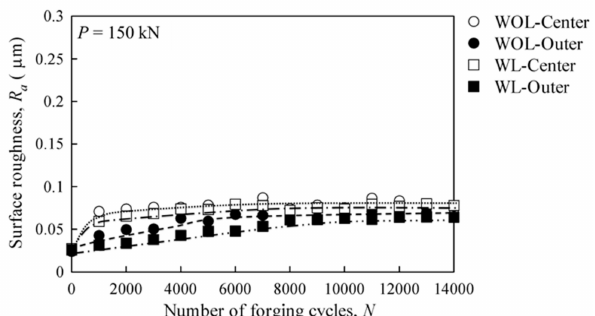
Figure 6. Average arithmetic surface roughness at the center and the average of outer areas by the number of forging cycles, for the 150 kN forging load. (WL—With Lubrication, WOL—Without Lubrication).